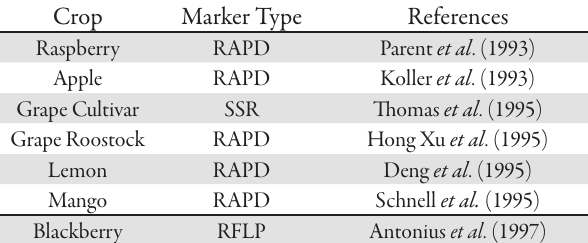
Tab. 7. DNA Markers for Varietal Identification Crop Marker